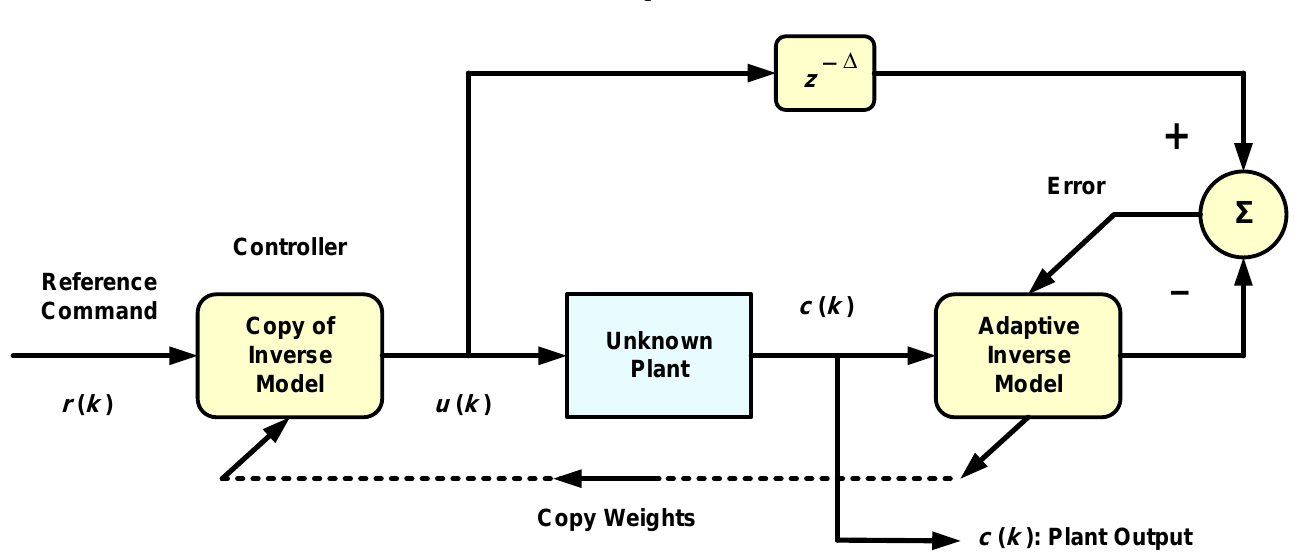
Figure 1. Adaptive inverse model control of an unknown plant [3].